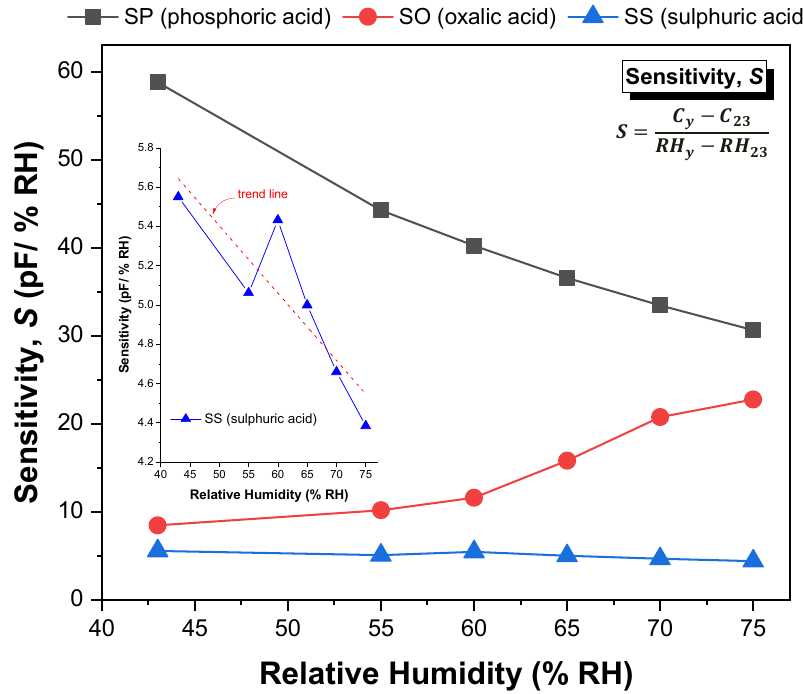
Figure 12. Sensitivity variation of the fabricated sensors as a function of humidity level. It is understandable that the sensitivity values reflect the behaviour of the capacitive response with the increment in humidity level, as explained in the previous paragraphs. It is observed that for the SP and SS sensors, the sensitivity decreases continuously as the humidity level increases (although SS sensor exhibits a linear-like decrease trend over the entire relative humidity range), while for the SO sensor the sensitivity increases with the increment in the humidity level (a more substantial increase for RH > 60%). The insert included in Figure 12 refers to the sensitivity of the SS sample to facilitate its comparative analysis with the other samples. The average sensitivity value of the SP sensor reaches up to 39 (pF/% RH), while in the case of the SO and SS sensors, the average sensitivity is around 14.5 and 4.8 (pF/% RH), respectively. These values are of the order of magnitude of those reported in [45], except for the value of the SP sample, which is relatively higher (about twice). The reason for this difference may be related with the structural differences or with a higher change of the dielectric constant due to water adsorption.